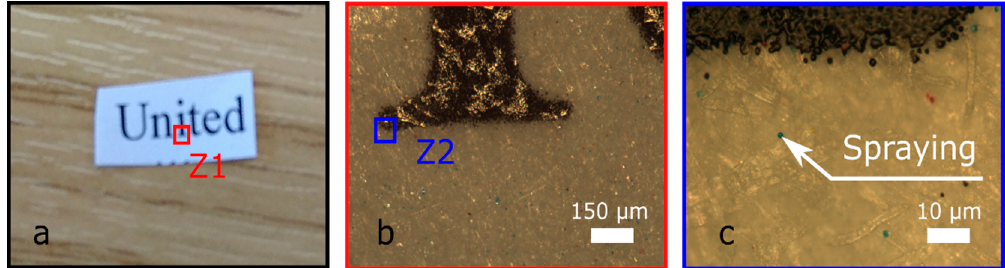
Figure A2. Spraying phenomenon observed on a pattern printed with a desktop inkjet printer on regular paper using standard coloured pigment ink. ( a ) The word “United”, printed, ( b ) zoom on the bottom part of the “i”, and ( c ) zoom on the bottom left corner of the “i”, showing spraying, comparable to the one observed with the CB ink.